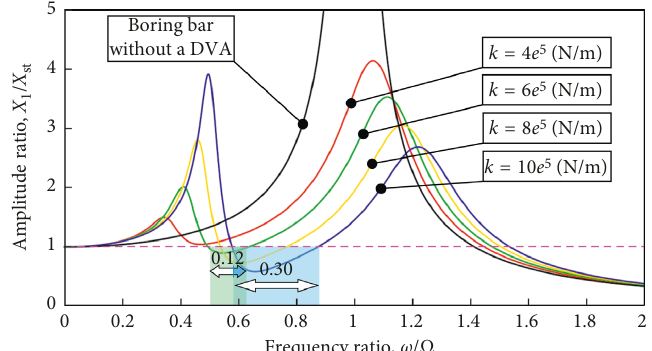
Figure 8: Amplitude ratio of the boring bar under different stiffnesses of the